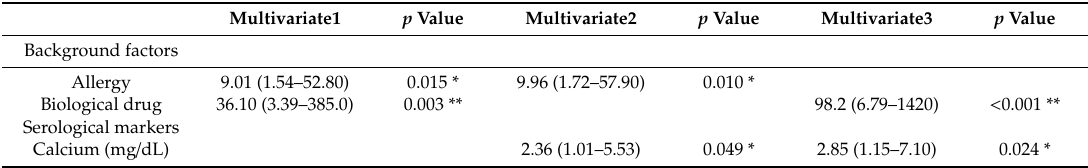
Table 5. Multivariate predictors of IRIS